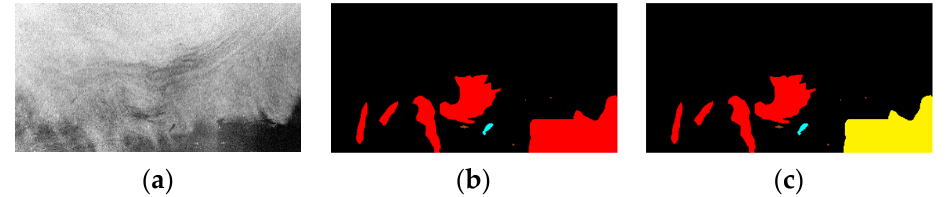
Figure 14. ( a ) Satellite image; ( b ) single ‘Oil Look-Alike’ type (red); ( c ) two ‘Oil Look-Alike’ types (red as Sharp and yellow as Patch Look-Alike).